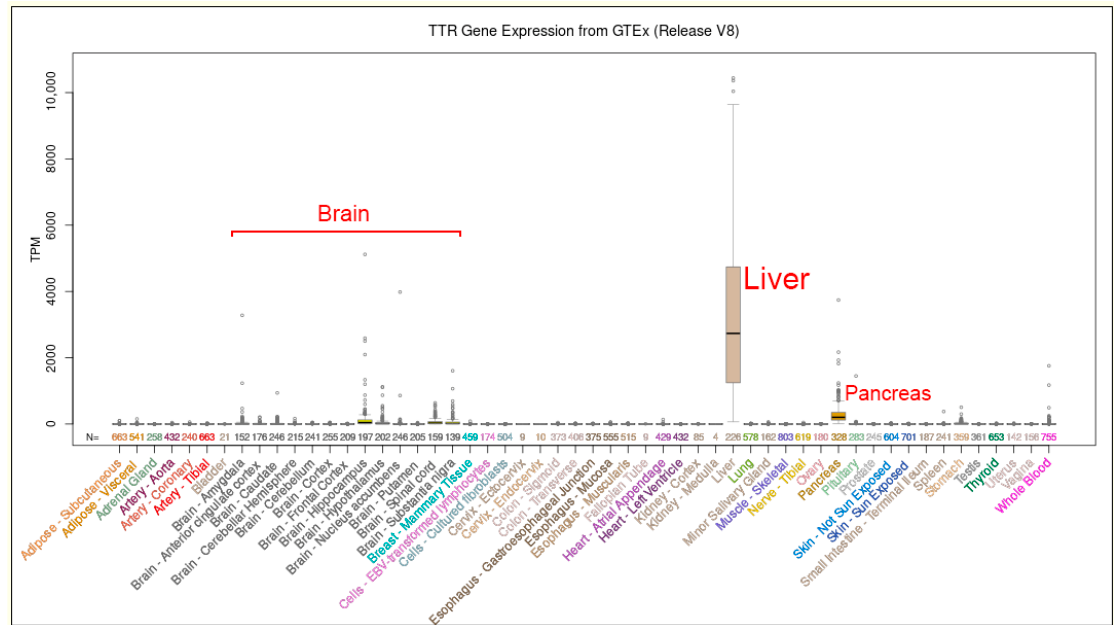
Figure 5. Expression level of the TTR gene in 54 healthy human tissues from GTEx RNA-seq of 17,382 samples from 948 donors (V8, Aug 2019). TPM: transcripts per million. Data and images from the UCSC Genome Browser (http://genome.ucsc.edu, accessed on 26 August 2022).